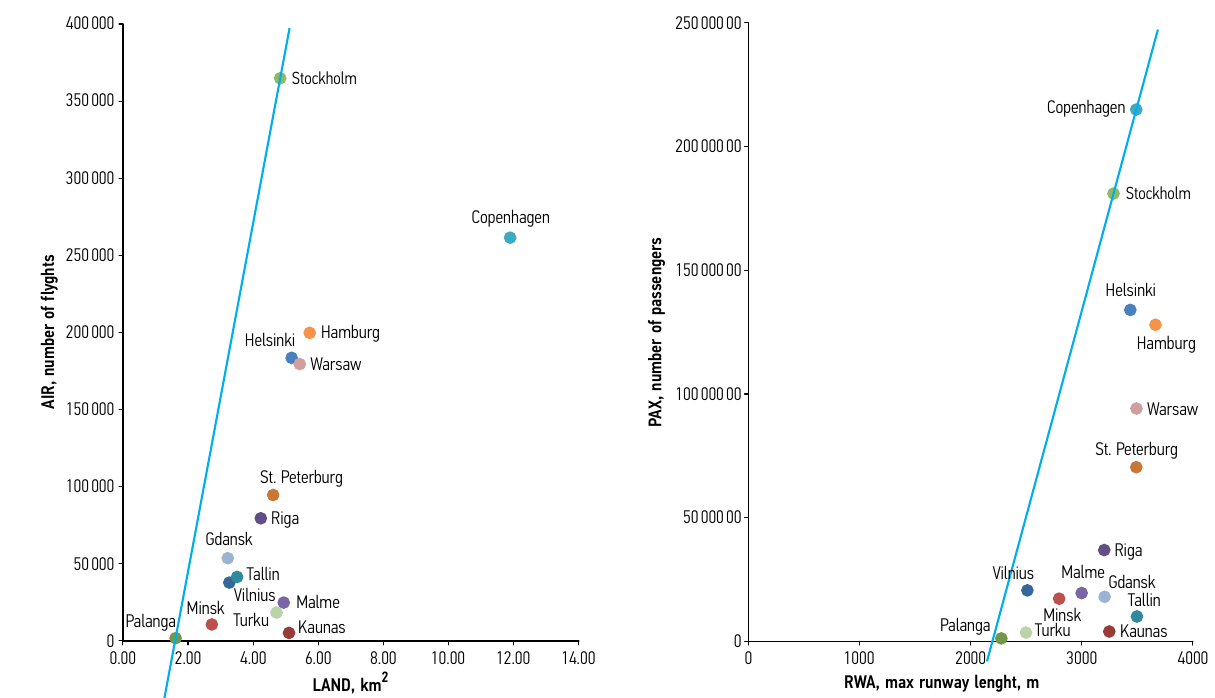
Fig. 4. DEA analysis based on AIR/LAND ratio Fig. 5. DEA analysis based on PAX/RWA